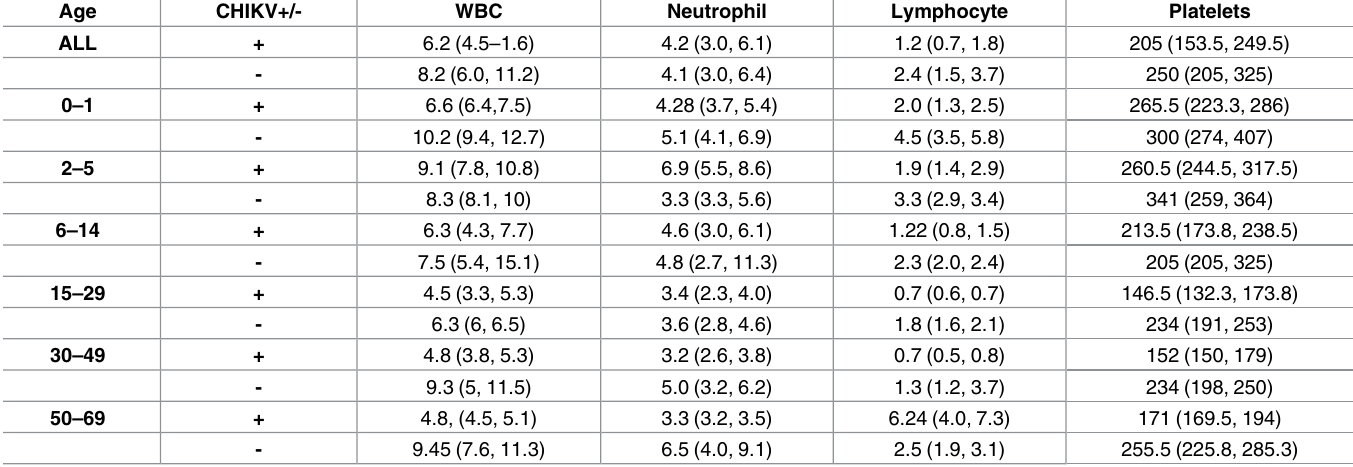
Table 4. Median values and interquartile range in parentheses for white blood cell (WBC) and differential counts for complete WBC, neutrophils, lymphocytes, and platelets by CHIKF positivity and age group.